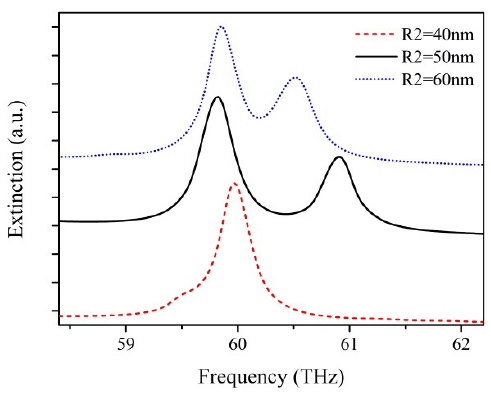
Figure 2. The extinction spectra of graphene hexamer with different radiuses of central nanodisk R 2